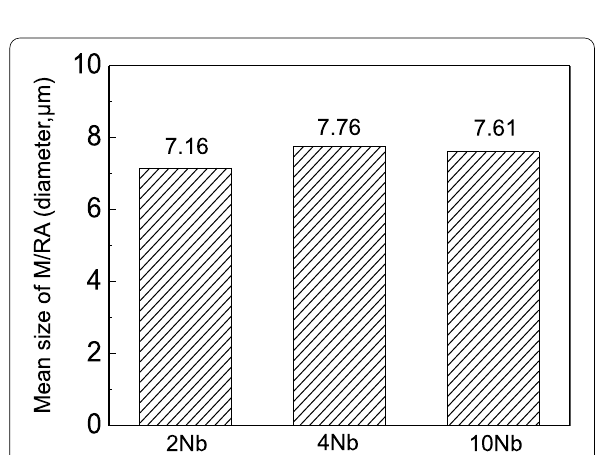
Fig. 14 Results of M/RA mean size based on different Nb contents